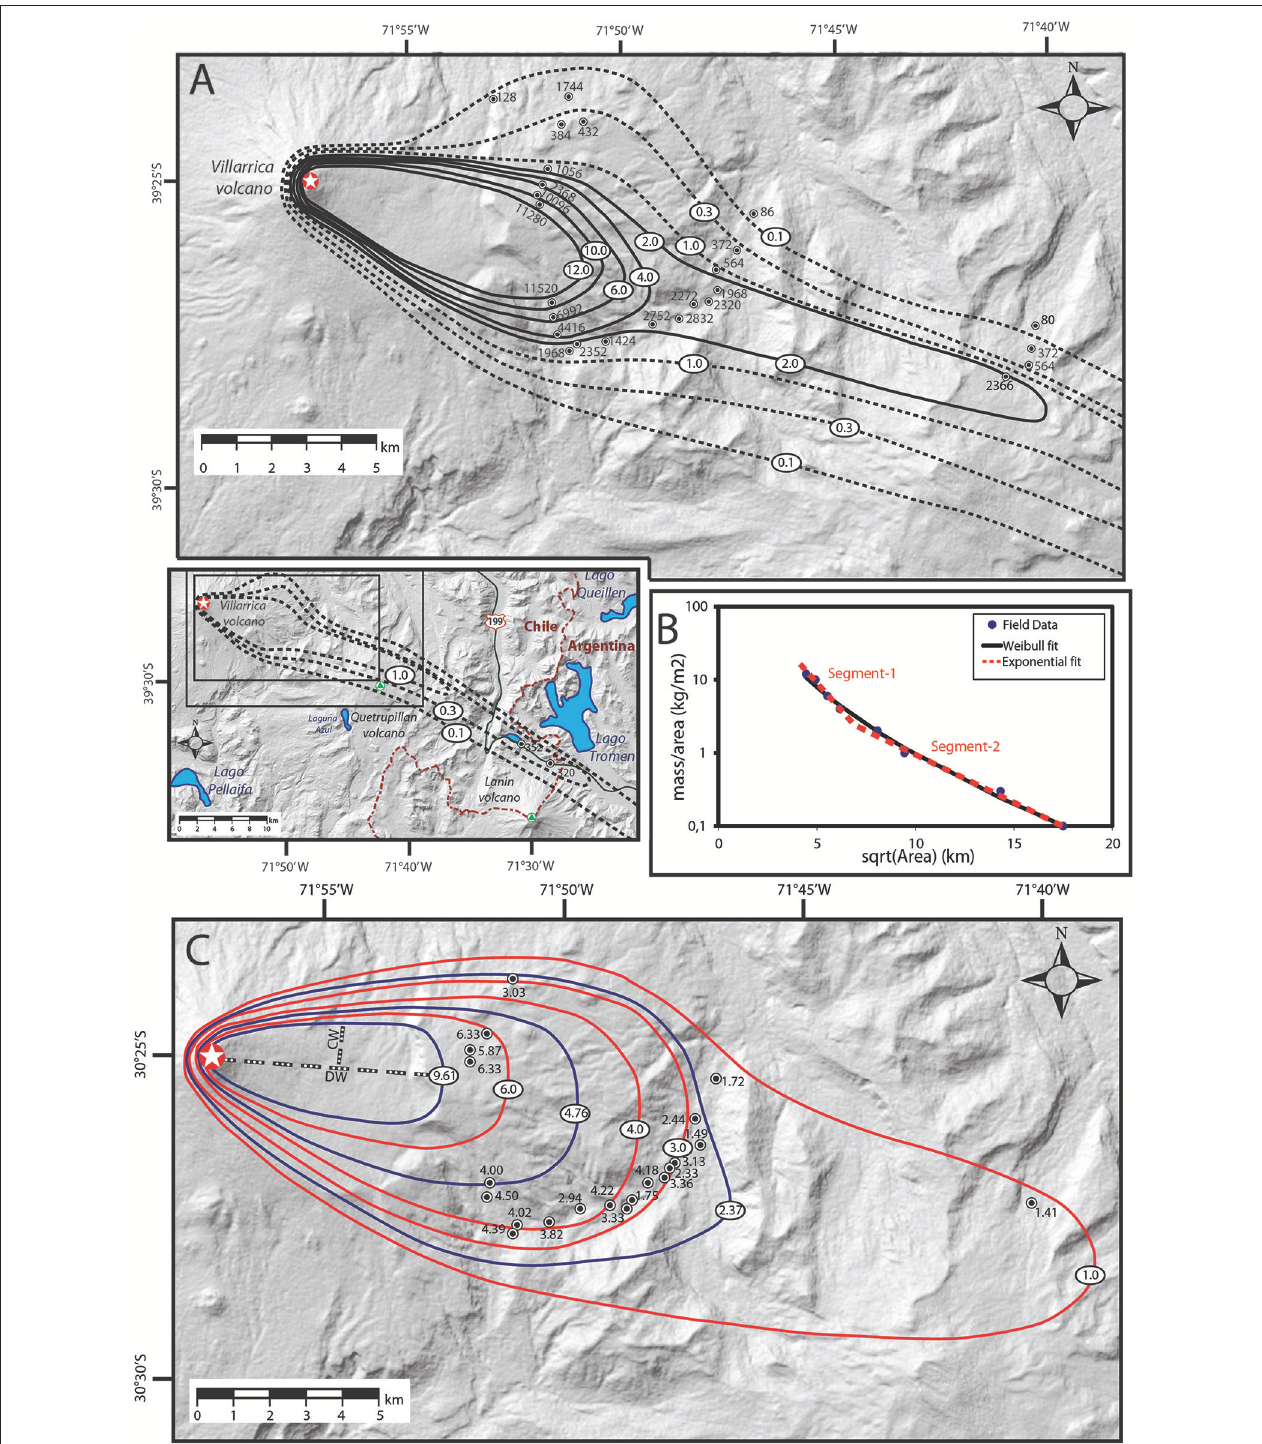
FIGURE 3 | Distribution of the tephra fall deposit. (A) Isomass map. Load values on isopachs are expressed in kg/m 2 , while field data are released in g/m 2 for detailed observation. Dotted lines represent isomass curves with uncertainty. (B) Load (kg/m 2 ) v/s square root area (km) plot for the tephra fall deposit. Both Weibull and Exponential (two-segment) best fits are plotted. (C) Isopleth map. Clast diameters are in cm, and the red curves are based on field data. Blue curves are result from interpolation and were used for the calculation of column heights following the method of Carey and Sparks (1986). DW and CW represent example downwind and crosswind axes, as these were used for the earlier